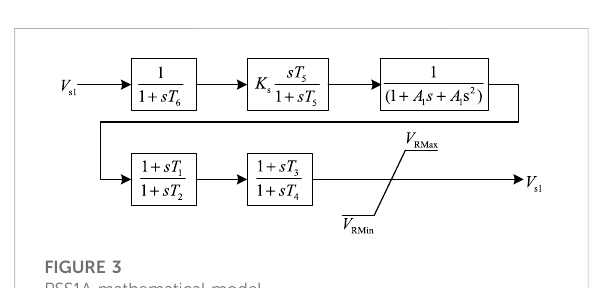
FIGURE 2 PSS general transfer function.